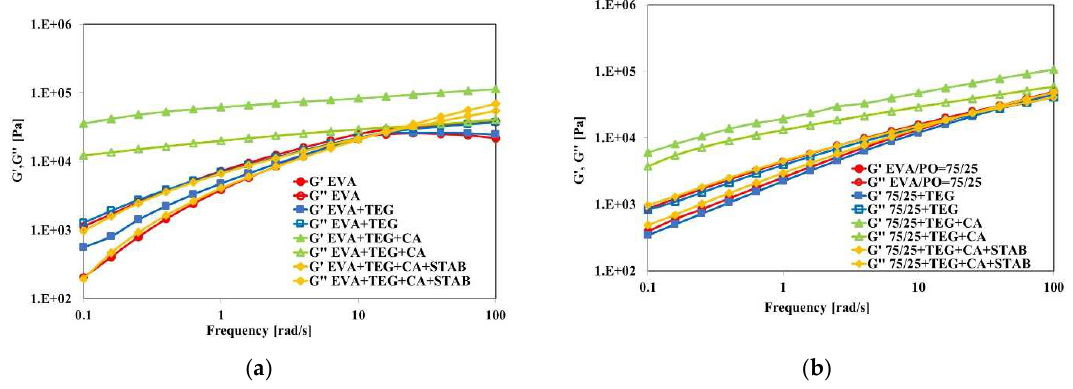
Figure 4. Storage (G’) and loss (G”) moduli of the ( a ) EVA and ( b ) EVA/PO = 75/25 wt.% samples with and without an adhesion promoter (TEG), a crosslinking agent (CA) and stabilizers (STAB).